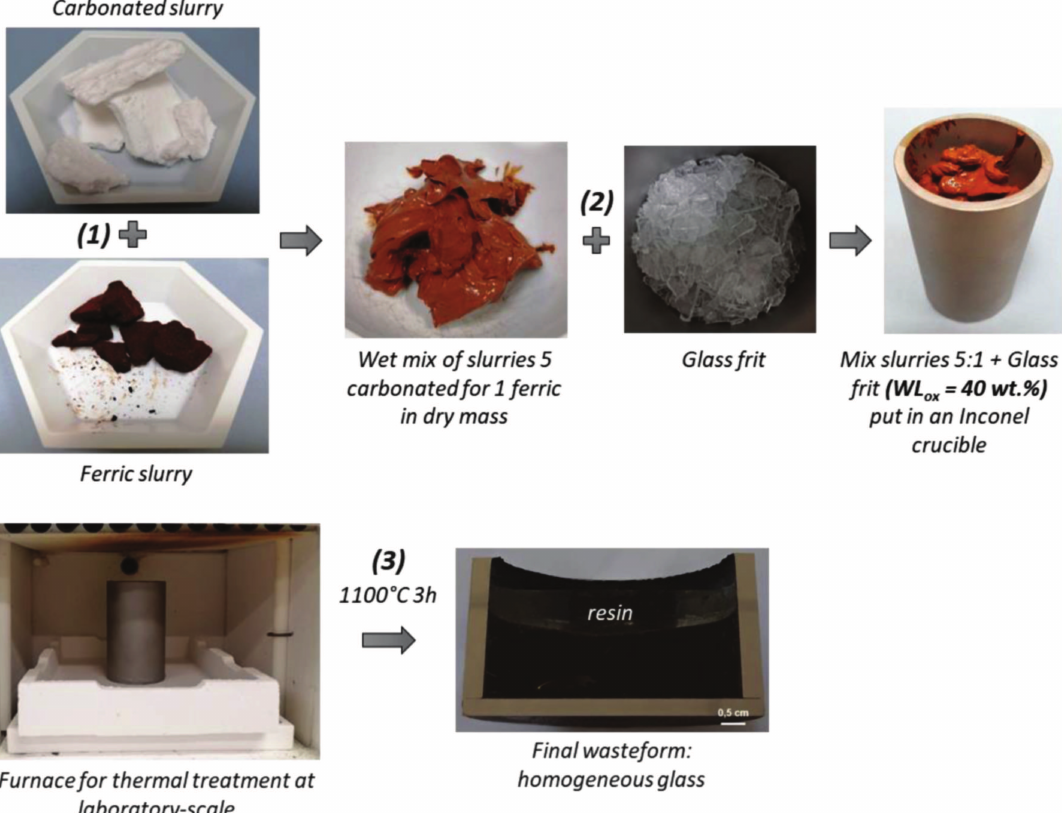
Fig. 2. (1) Mixture of the two slurries, (2) mixture of mixed slurries with the glass frit placed in a crucible (3) thermal treatment in a muffle furnace and crucible cut in the height direction to see the material. An epoxy resin is poured after the thermal treatment to maintain the material during